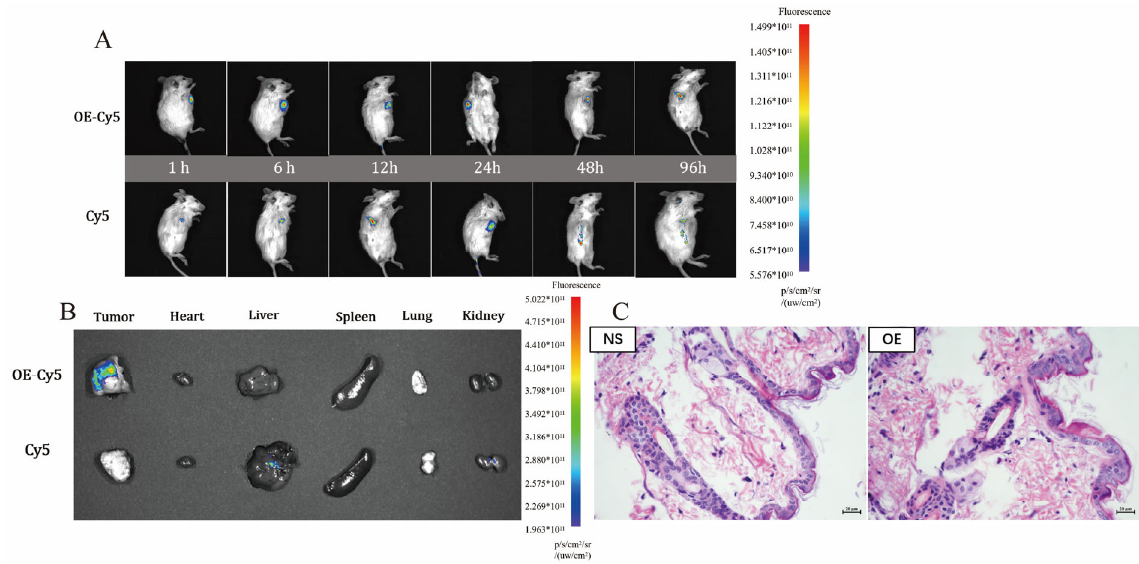
Figure 4. In vivo fluorescence images of tumor ‐ bearing mice over time after administration ( A ), and ex vivo fluorescence images of five major organs harvested from the tumor ‐ bearing mice ( B ) in the free Cy5 and OE ‐ Cy5 groups. H&E ‐ based immunohistochemical images of skin tissue after the free Cy5 and OE-Cy5 groups. H&E-based immunohistochemical images of skin tissue after subcutaneous injection of normal saline and blank OE peptide hydrogel ( C ). subcutaneous injection of normal saline and blank OE peptide hydrogel ( C